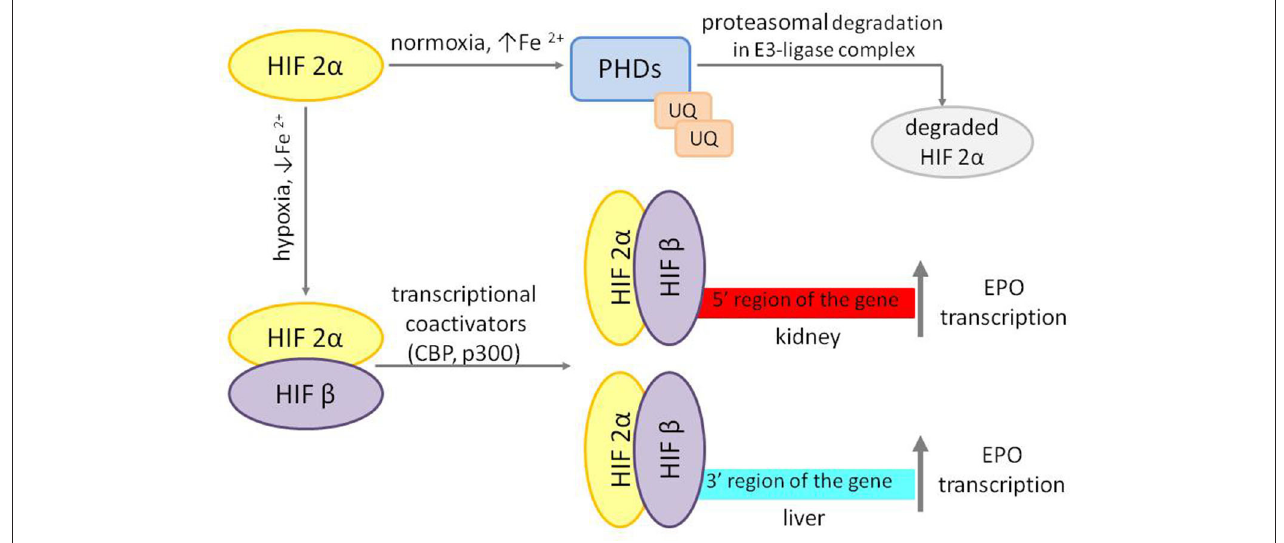
FIGURE 1 | Regulation of EPO transcription. HIF 2 α , hypoxia-inducible factor 2 α ; HIF β , hypoxia-inducible factor β ; PDHs, O 2 and iron-dependent HIF prolyl-4-hydroxylases; UQ, ubiquitin; CBP, CREB-binding protein; EPO, erythropoietin.